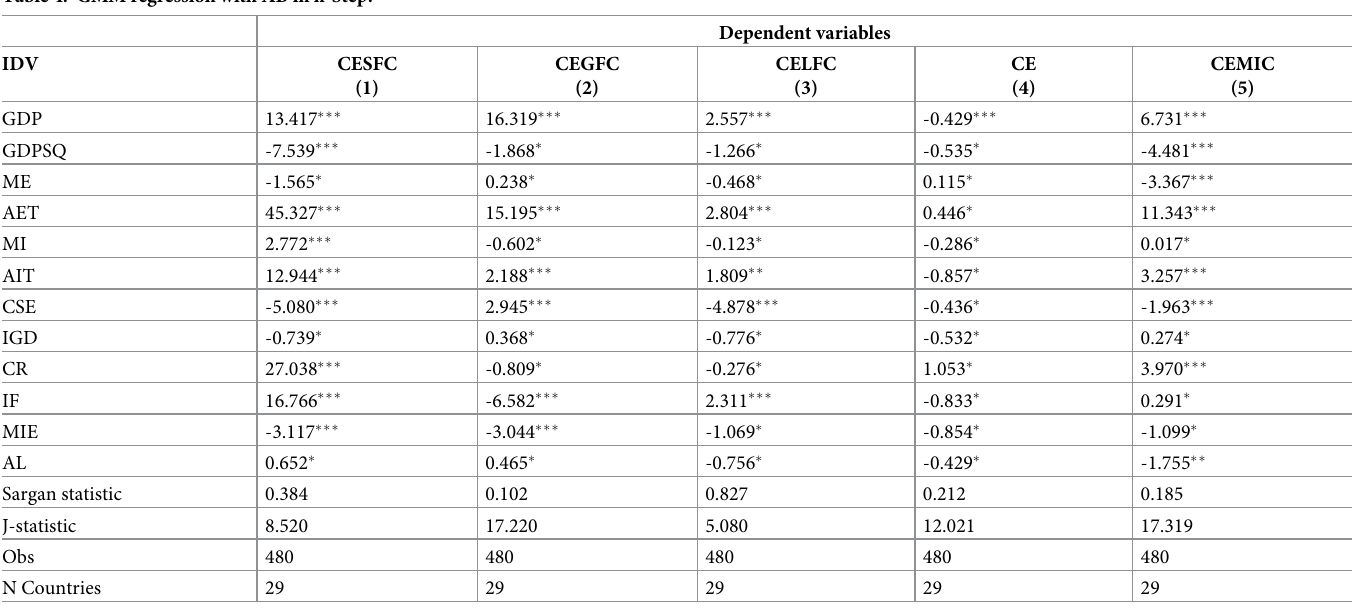
Table 4. GMM regression with AB in